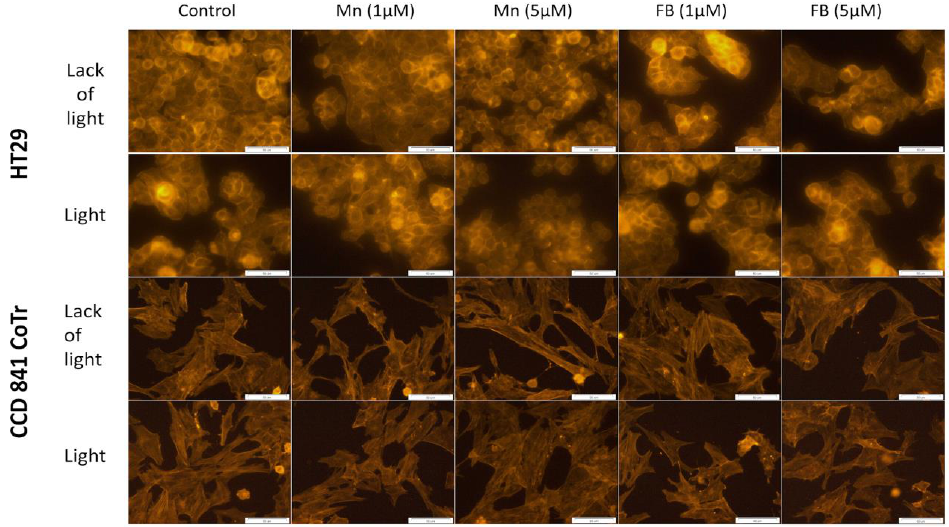
Figure 9. F-actin staining; first column: control of cells, second column: Mn porphyrin 1 µM, third column: Mn porphyrin 5 µM, fourth column: FB porphyrin 1 µM and fifth column FB porphyrin 5 µM; first line: no irradiation conditions (HT29), second line: white light irradiation (HT29), third line: no irradiation conditions (CCD 841 CoTr) and fourth line: white light irradiation (CCD 841 CoTr). Bar 50 µm.